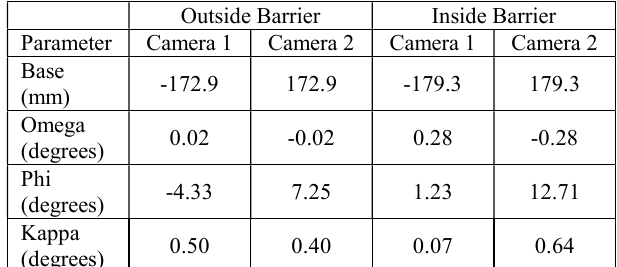
Table 3. Relative orientation parameters.